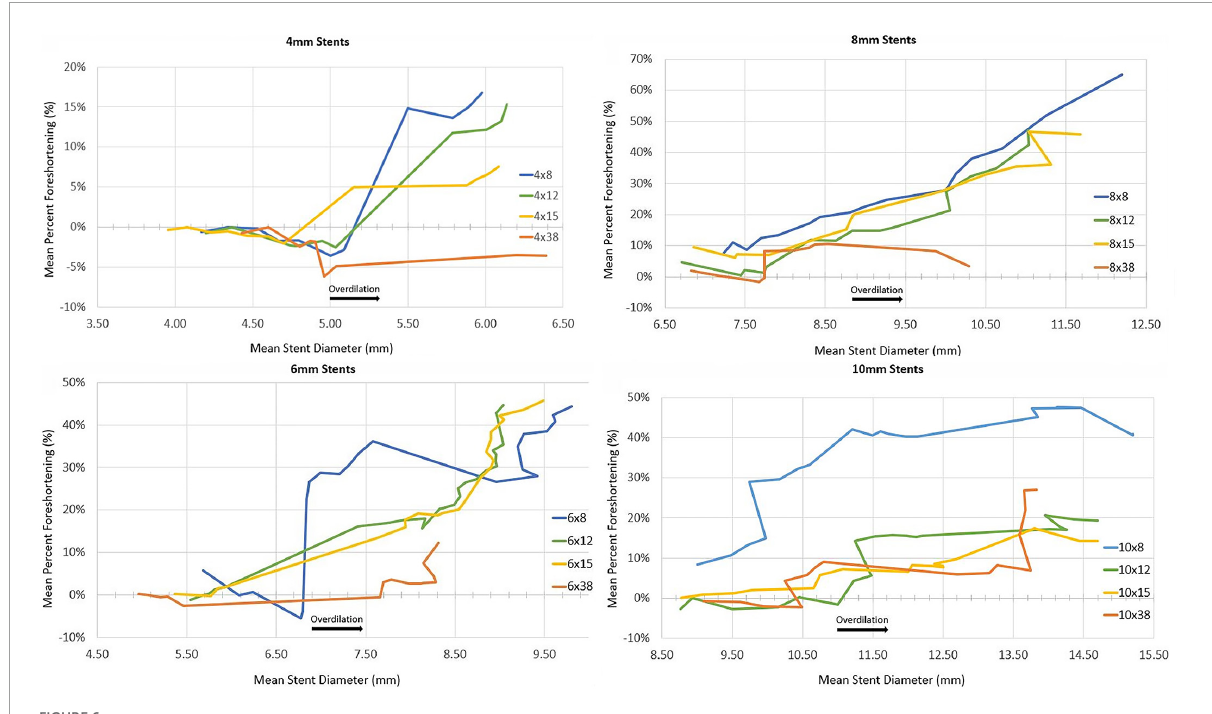
FIGURE6 Mean percent foreshortening with increasing mean stent diameter.